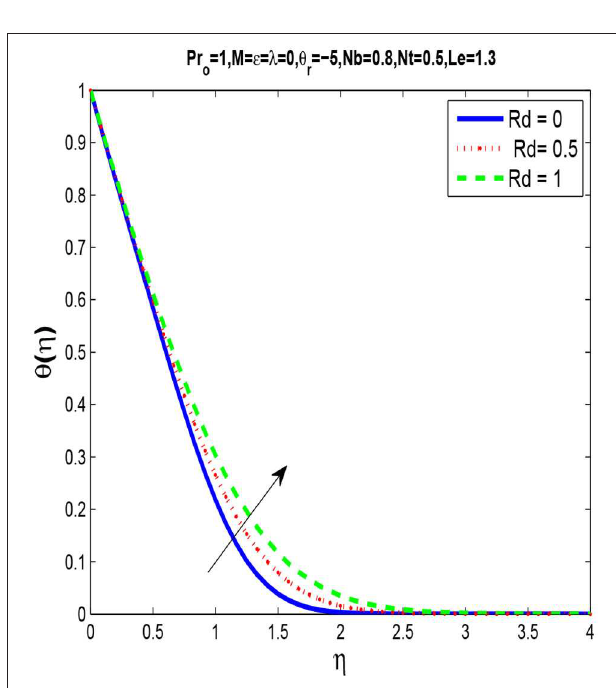
FIGURE 10 | Temperature profile θ ( η ) for different Rd ( For Case B).